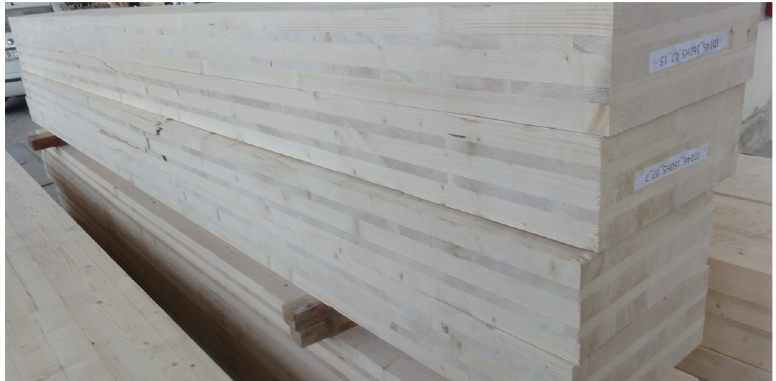
Figure 14. Failure of the 5-layer CLT panel after the experimental testing (the whole specimen).